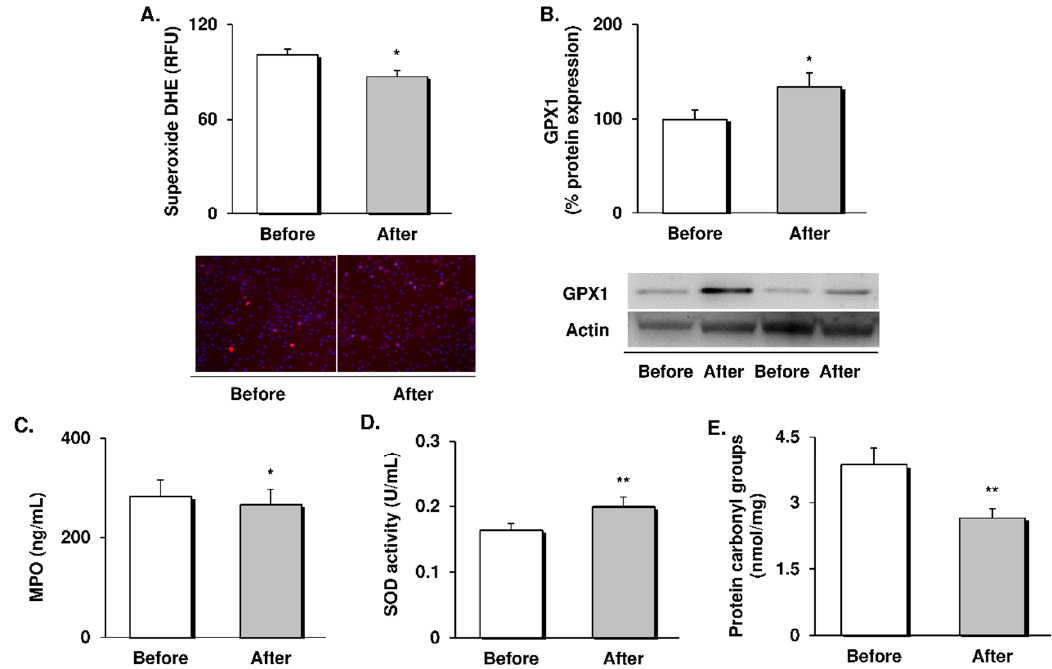
Figure 1. Evaluation of prooxidant / antioxidant responses and oxidative stress markers in obese patients before and 12 months after RYGB intervention. ( A ) Superoxide production in leukocytes, measured as arbitrary units of DHE fluorescence and their representative fluorescence microscopy 100 × images ( n = 17). ( B ) Levels of GPX1 protein expression in leukocytes and representative Western blot images ( n = 20). ( C ) MPO levels ( n = 46) and ( D ) SOD activity in serum. ( E ) Carbonyl groups in serum proteins ( n = 14). Data are represented as the mean + SE. * p < 0.05 ** p < 0.01 when compared using a paired Student’s t-test. RYGB: Roux-en-Y gastric bypass; DHE: Dihydroethidium; RFU: Relative fluorescence units; GPX1: Glutathione peroxidase 1; MPO: Myeloperoxidase; SOD: Superoxide